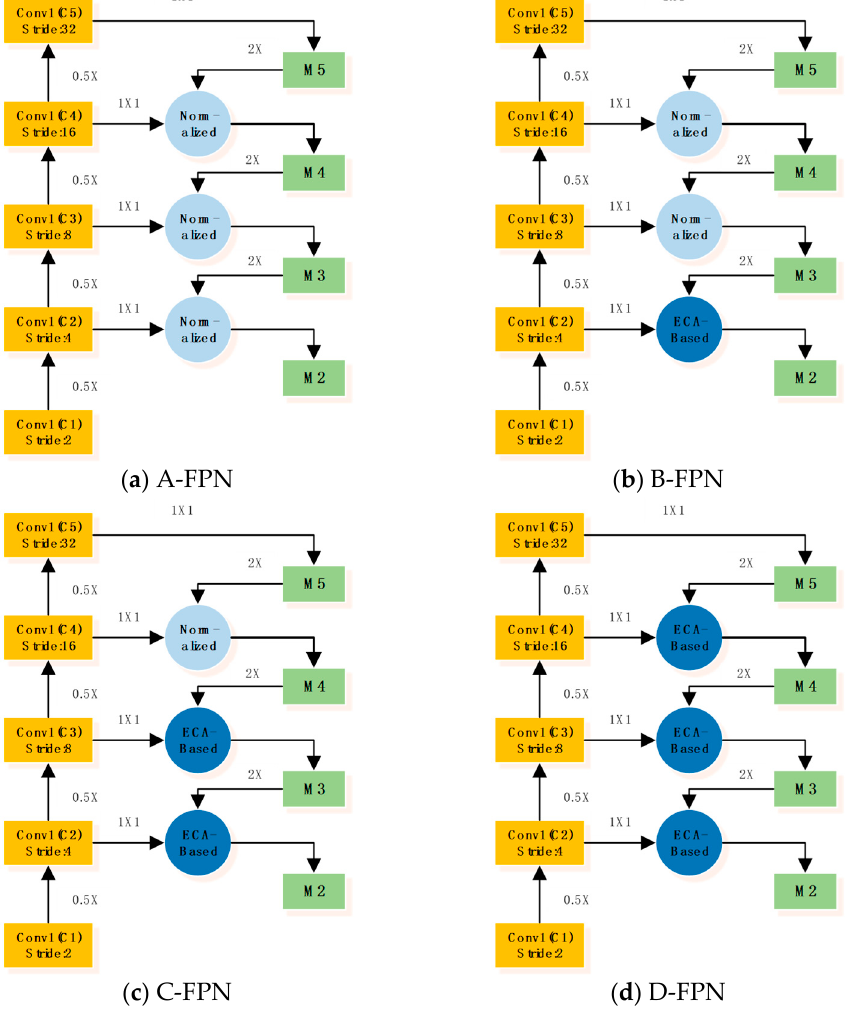
Figure 6. Hybrid weighted feature fusion of FPN.